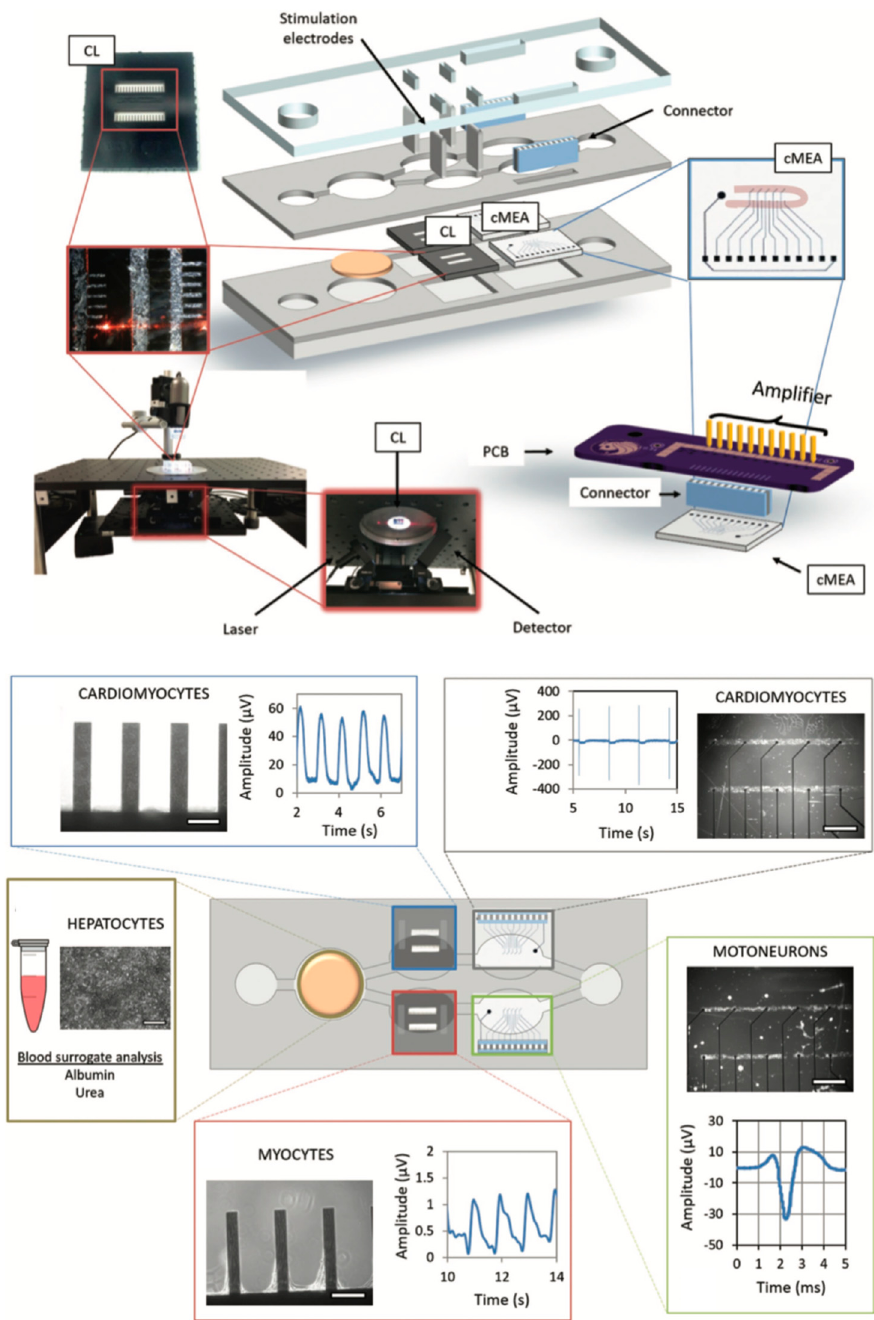
Figure 13. Non-invasive monitoring of cellular function in a 4-organ system measuring the mechanical and electrical functional activity of cardiomyocytes and motoneurons as well as secretion of hepatocytes. (Reproduced from [69])